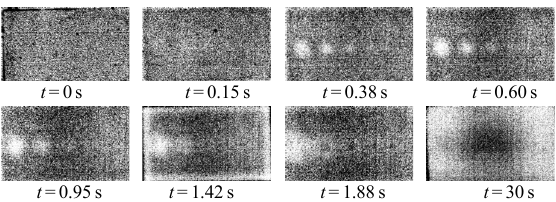
Fig. 13 Raw thermal images sequence of the specimen 2#.